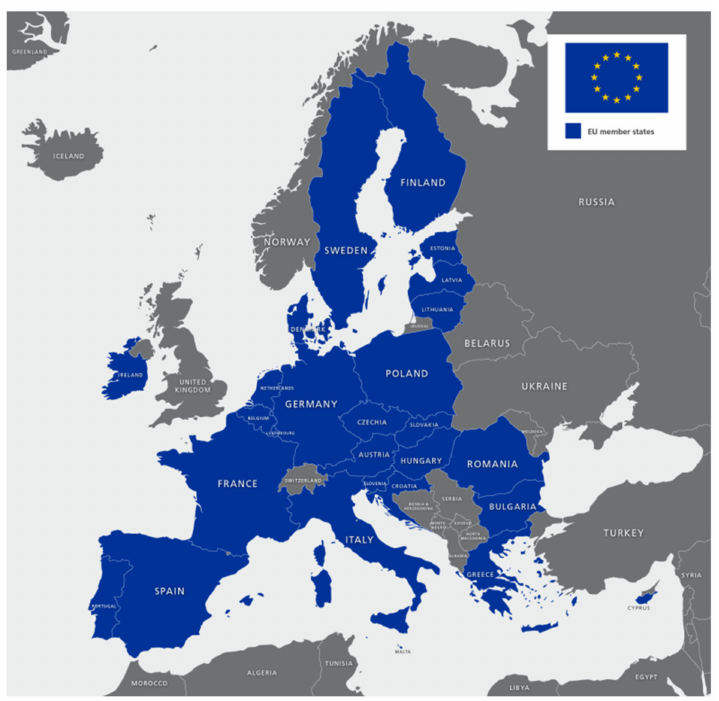
Figure 1. Map of the European Union (EU, countries shown in blue)